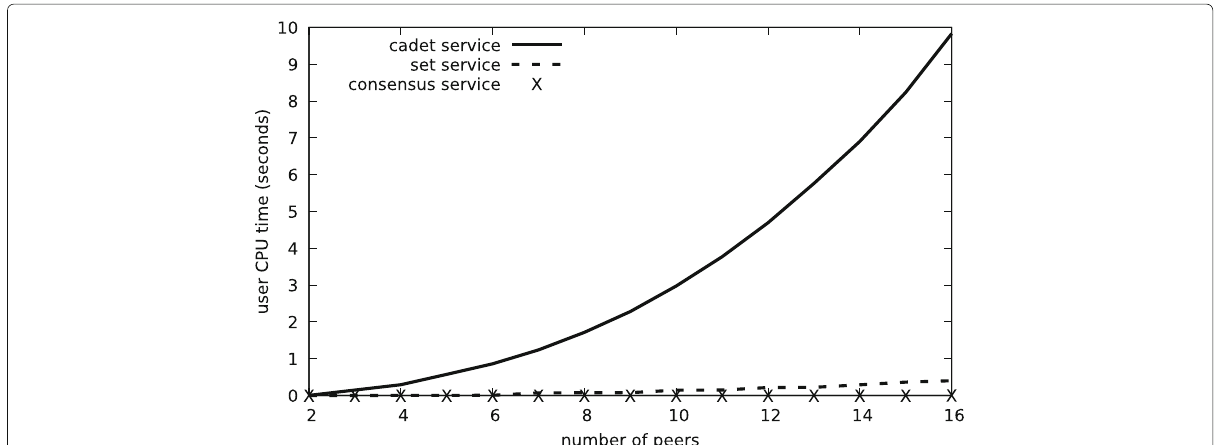
Fig. 7 CPU of BSC for 100 elements of 64 bytes and only correct peers. Average over 50